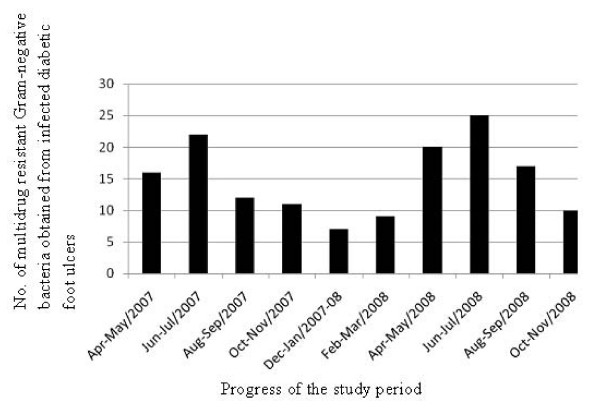
Distribution of multidrug resistant Gram-negative bacteria obtained from infected diabetic foot ulcers divided into 2-month periods from April 2007 to November 2008.